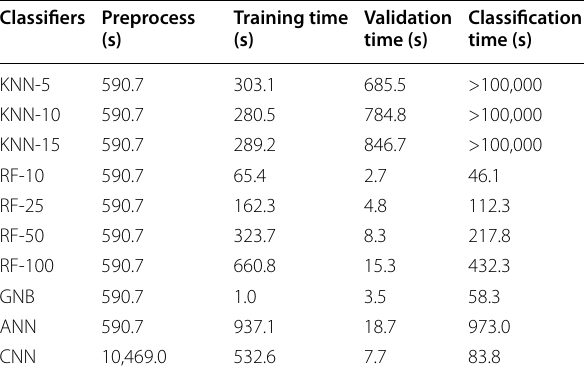
Table 2 The computational efficiency for different machine learning algorithms in preprocessing, training, validating, and classifying Classifiers Preprocess